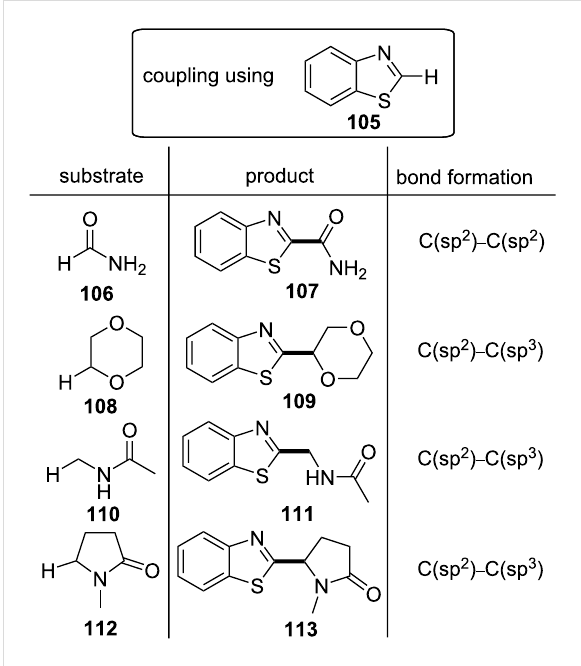
Scheme 26: Benzaldehyde-mediated photoredox CDC reaction: com- patible amides and